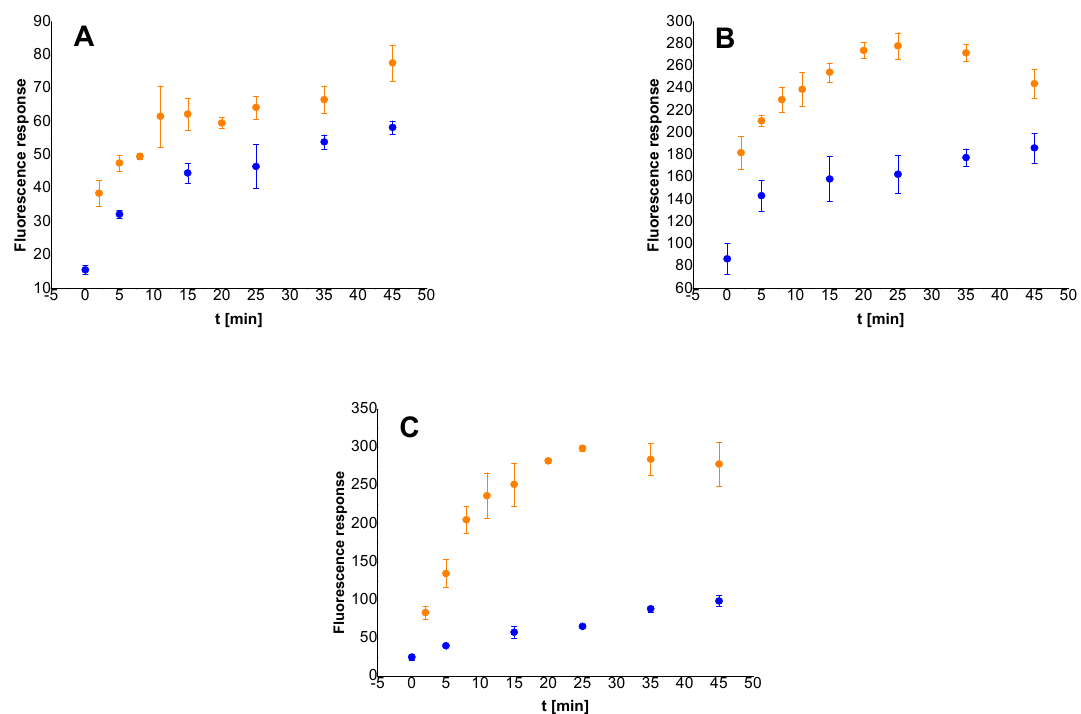
Figure 4. Time dependent fluorescence response of dissolved released fragment from the ITP bound to TentaGel XV RAM resin ( A ), H-Rink amide ChemMatrix resin ( B ) and Rink Amide PEGA resin ( C ) in the presence (yellow dots) and absence (blue dots) of trypsin (25 µg/mL). The probe (2.0–2.1 mg) was dispersed in Tris-HCl buffer (0.1 M; 1 mL). Fluorescence emission was measured at 480 nm after excitation at 410 nm. Detector voltage was set to 600 V.